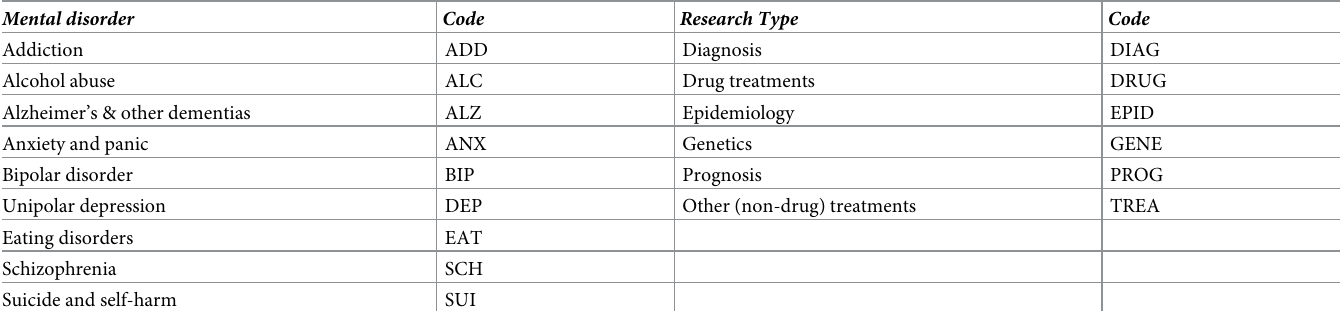
Table 3. List of mental health disorders and research types (or domains) subject to analysis, and their trigraph and tetragraph codes. Mental